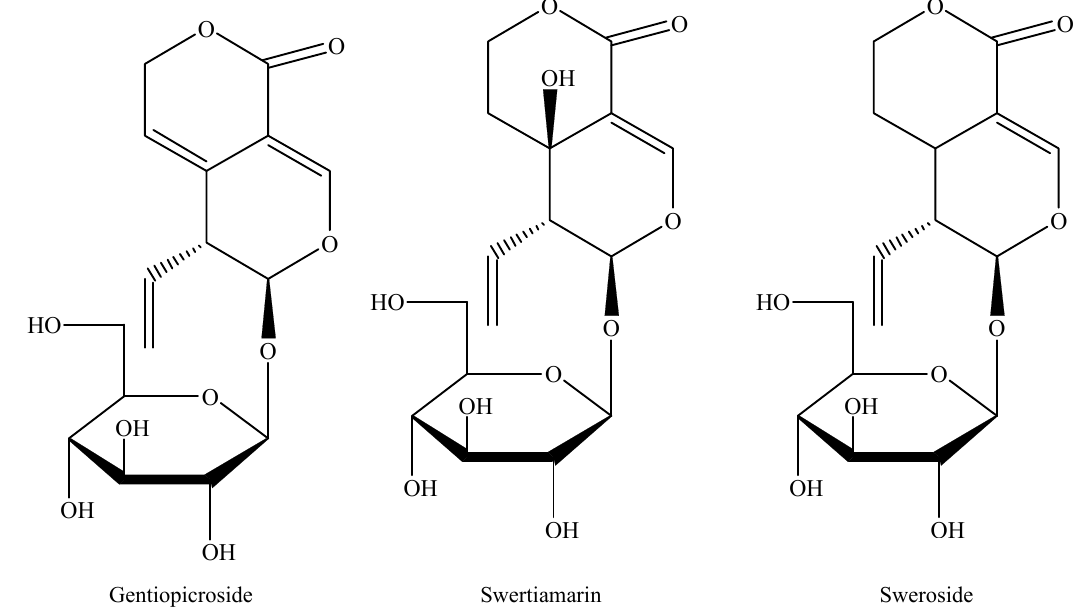
Figure 1. The structures of the reference standards.